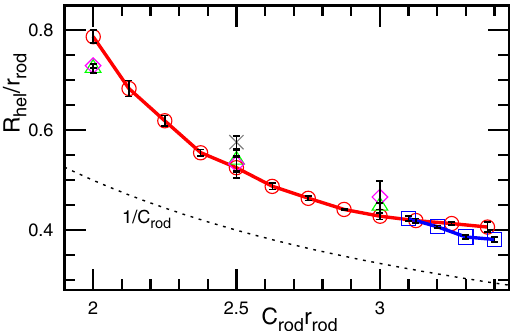
Figure 3. Radius R hel of the rod assembly of the helical-cylinder shape for the chiral rods with ( ⚬ , Δ , ◊ ) and without ( ◽ , × ) direct side-to-side attractive interactions. The circles and squares represent R hel of the rods at R cyl / r rod = 1.18 and N = 4800. The triangles and diamonds are for R cyl / r rod = 1.18 and 1.31, respectively, at N = 9600. For the side-to-side attraction, ε / k B T = 3 is used. The cross represents R hel of the tubules protruded from flat membranes at φ rod = 0.4. The dashed line shows the curvature radius of the rods 1/ C rod .